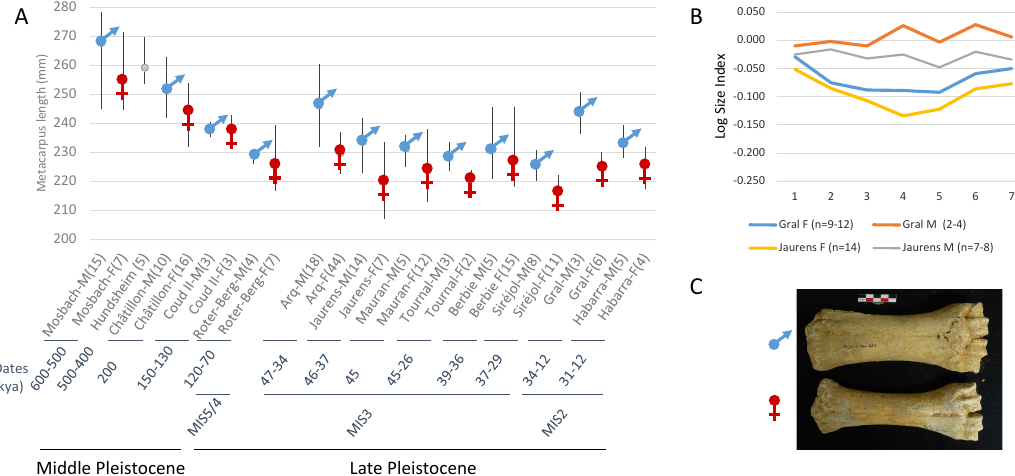
Figure 3. Sex-specific differences in bison metacarpus bone morphology. ( A ) Variations of the length of the metacarpi (minimal-average-maximal in mm) of a selection of series of Pleistocene bison for both sexes plotted in a chronological order from the most ancient at the left to the most recent ones at the right. Note the chronological gap between Middle Pleistocene and Later Pleistocene series (number of samples in bracket). ( B ) Log size index, LSI, of metacarpi from the Upper Pleistocene sites of the Igue du Gral and Jaurens (Jaur) in France according to their sex (M = male, F = female). Measurements: 1 = maximal length, 2 = proximal TD, 3 = proximal APD, 4 = middle of diaphysis TD, 5 = middle of diaphysis APD, 6 = distal TD, 7 = distal APD, 8 = sus-articular distal TD. ( C ) Bison